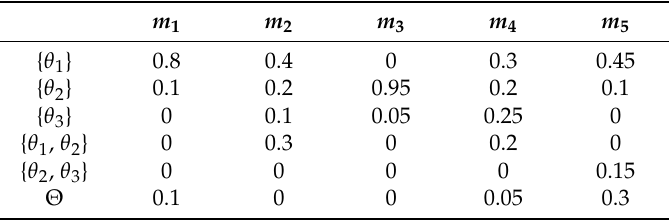
Table 1. Five BPAs corresponding to five